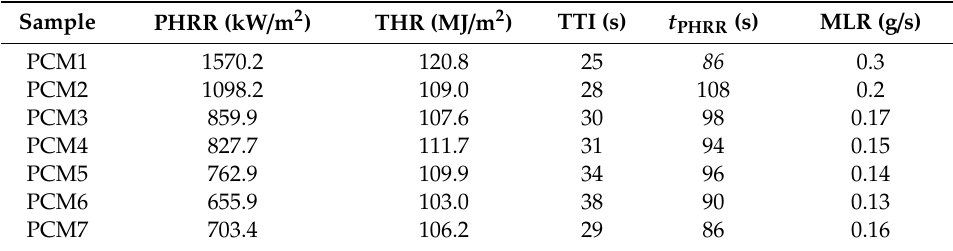
Table 5. Flammability data of the samples used in this study.